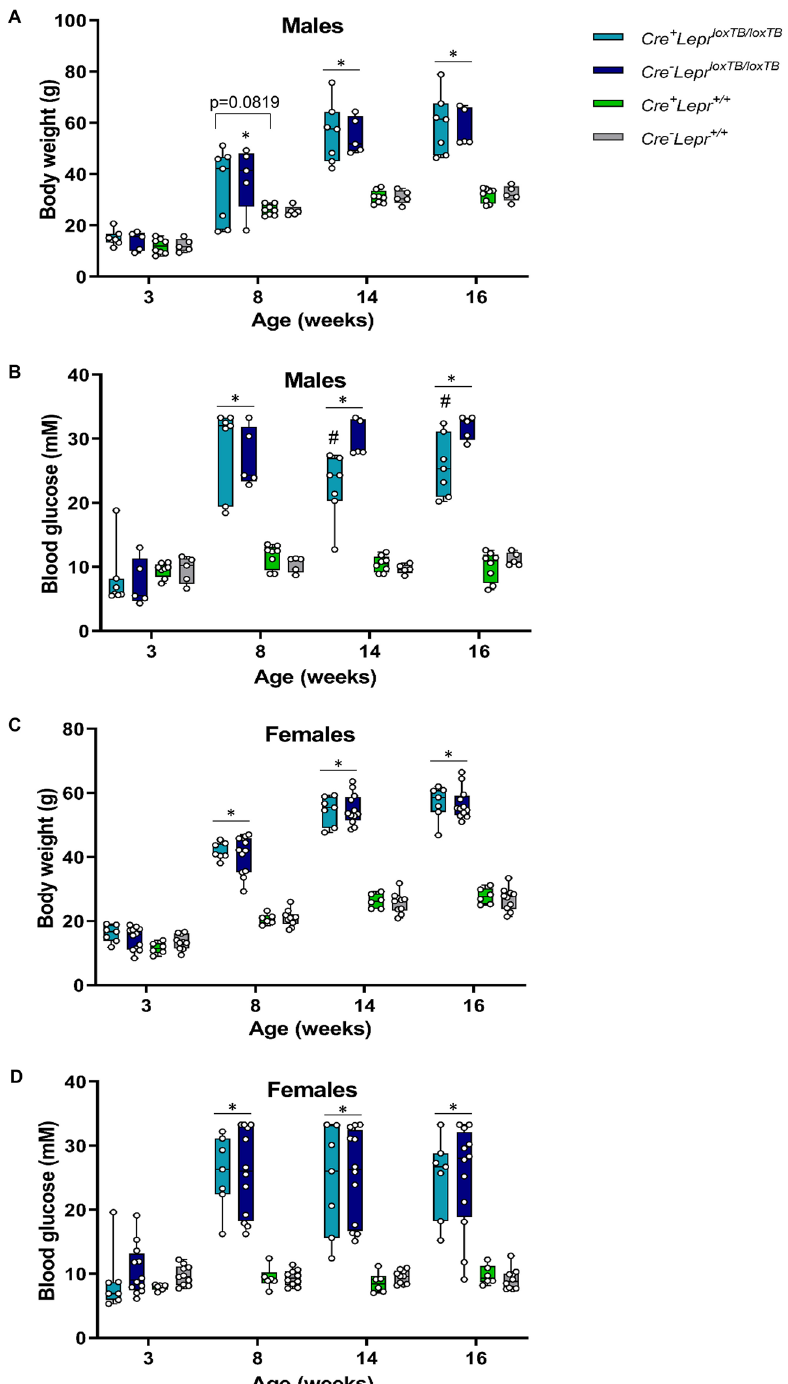
Figure 1. Body weight ( A , C ) and blood glucose ( B , D ) of mice from the Lepr reconstitution study at different ages. Parameters obtained after a 4 h fast. In ( A ) and ( B ), n = 7 for Cre + Lepr loxTB/loxTB , n = 5 for Cre − Lepr loxTB/loxTB , n = 8 for Cre + Lepr + / + , and n = 5 for Cre − Lepr + / + . In ( C ) and ( D ), n = 7 for Cre + Lepr loxTB/loxTB , n = 12 for Cre − Lepr loxTB/loxTB , n = 6 for Cre + Lepr + / + , and n = 10 for Cre − Lepr + / + . Performed repeated measures two-way ANOVA with post-hoc analysis. *p < 0.05, Cre + Lepr loxTB/loxTB and Cre − Lepr loxTB/loxTB vs. Cre + Lepr + / + and Cre − Lepr + / + (except in A at 8 weeks old, where *p < 0.05, Cre − Lepr loxTB/loxTB vs. Cre + Lepr + / + and Cre − Lepr + / + ); # p < 0.05 vs. Cre − Lepr loxTB/loxTB . Main effect of time (p < 0.05) in ( A – D